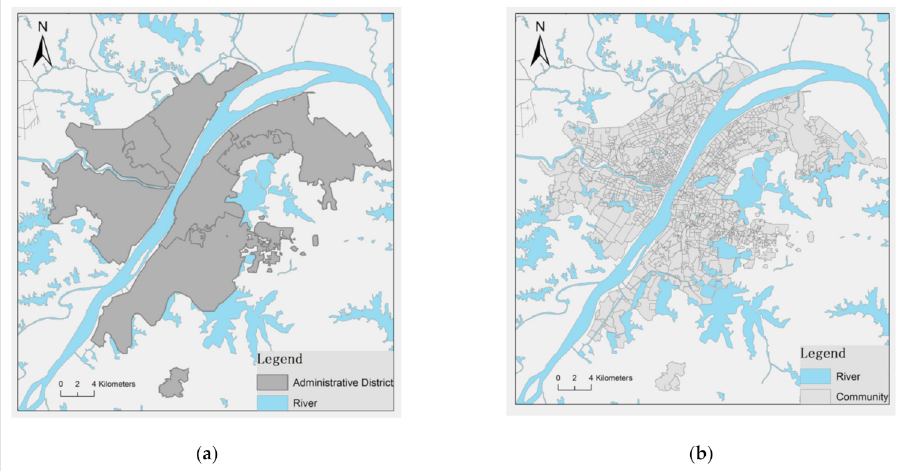
Figure 1. Study area mapping. ( a ) The central urban area in Wuhan; ( b )The distribution of communi- ties in the study